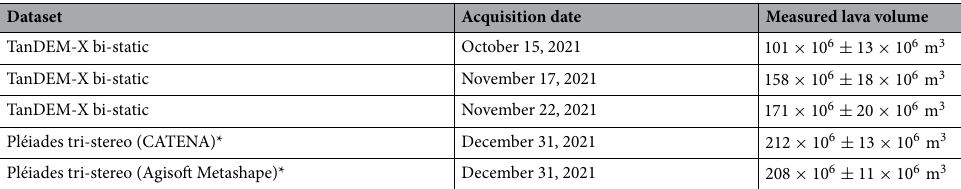
Table 1. Volume estimates based on VHR satellite data (*the software packages CATENA and Agisoft Metashape follow different processing schemes, cf. “DSM generation and lava volume estimates from optical tri-stereo data” section).